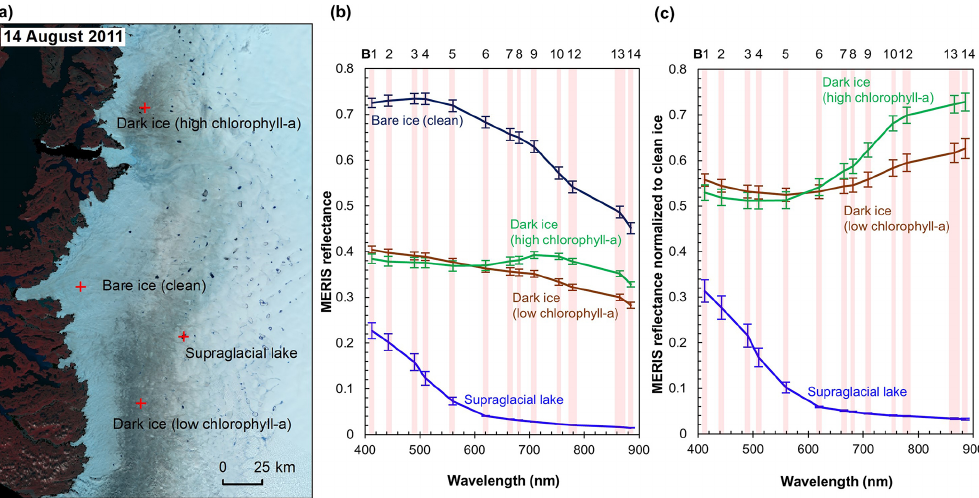
Figure 3. MERIS spectra of different surface types. (a) MERIS Level-2 image (false color composite) acquired on 14 August 2011 and locations of the four sample sites. Each site has an area of 1.2km × 1.2km composed of 16 MERIS pixels. (b) MERIS reflectance in 13 spectral bands over the four sites, illustrated by mean and SD values for each band over each site. (c) Normalized reflectance relative to the clean ice spectra. Table 2. Calculated ratio indices and surface reflectance at 620nm over the four sites. Surface type 2BDA 3BDA NDCI MCI Impurity R 620nm Bare ice (clean) 0.960 − 0.037 − 0.021 0.011 0.457 0.683 Dark ice (high chlorophyll a ) 1.035 0.035 0.017 Dark ice (low chlorophyll a ) 0.986 − 0.014 Supraglacial